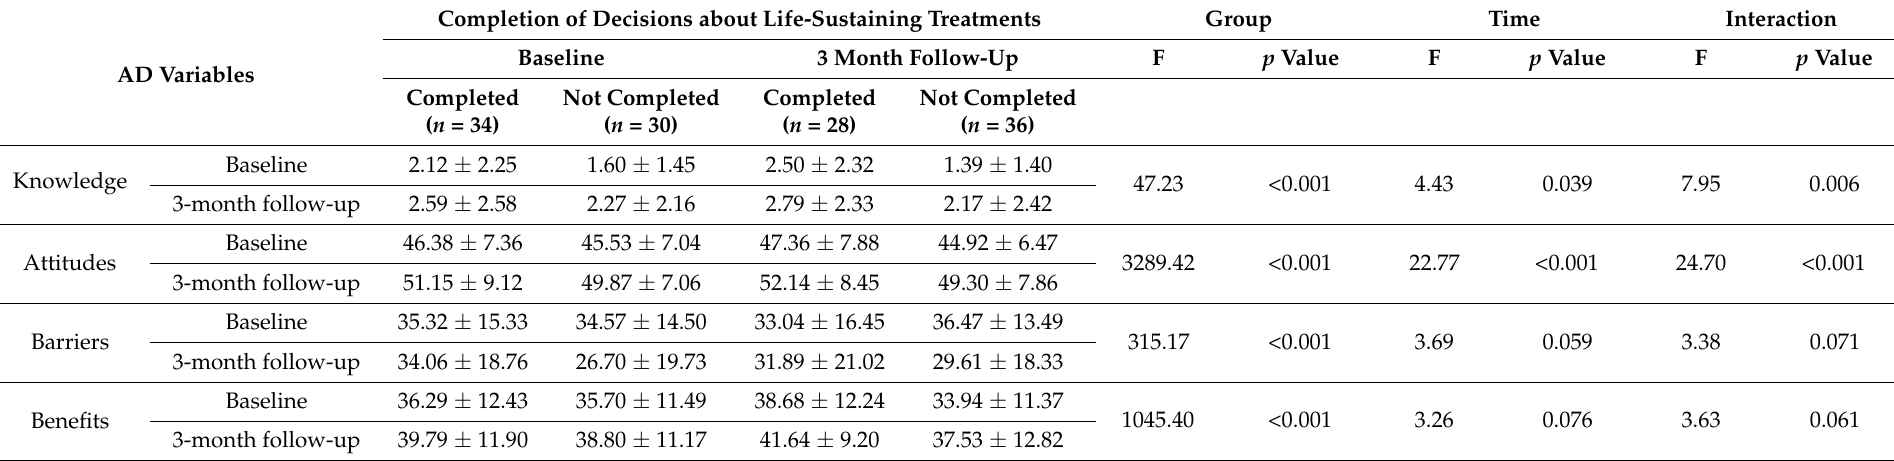
Table 3. Relationships of changes in knowledge about advance directives, attitudes, and barriers/benefits with changes in completion of the decisions about life-sustaining treatments from baseline to 3-month